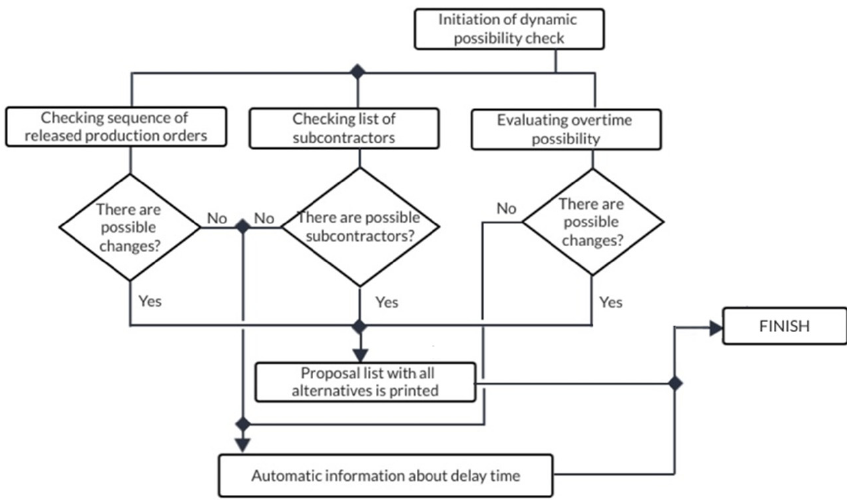
Figure 4. Dynamic Decision Support Module for presence of employees.